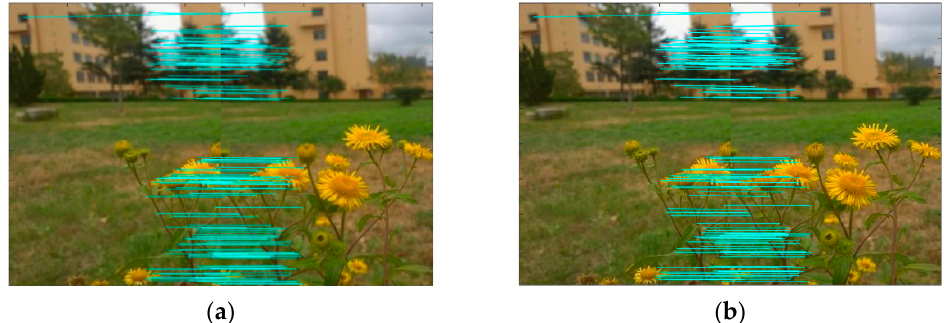
Figure 7. The registered images for T1: ( a ) I-RANSAC; ( b ) IIR. The blue line indicates the corresponding matching points of the two pictures. The registration accuracy of T1( a ) is 89.20%, and that of T1( b ) is 91.37%, as shown in Table 3.